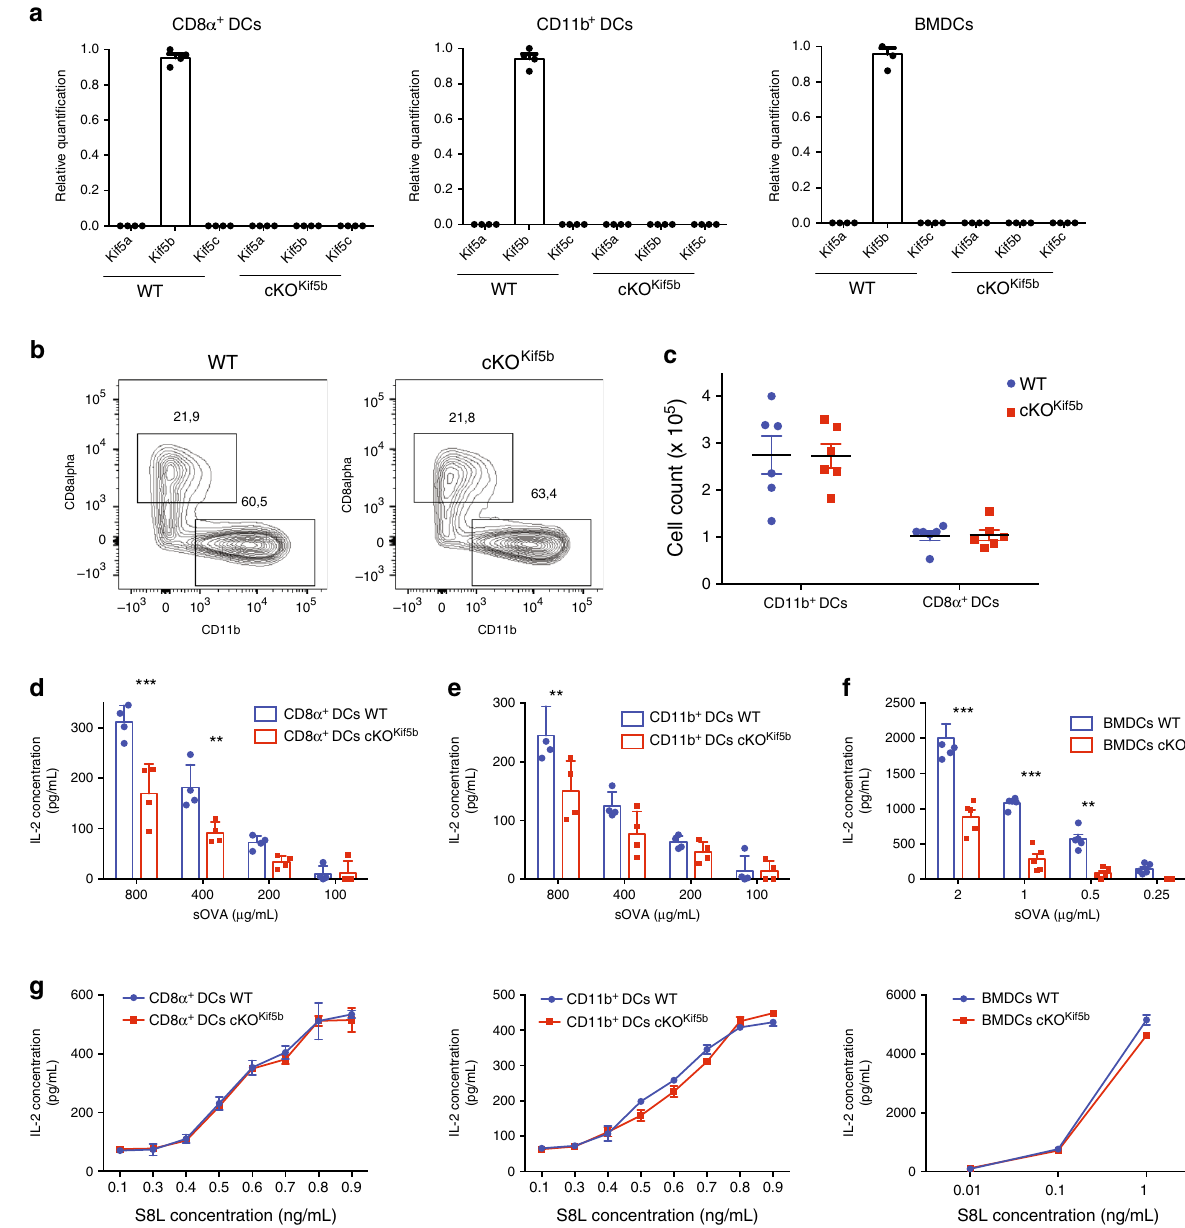
Fig. 1 Kinesin-1 regulates cross-presentation. a Relative quanti fi cation of Kif5a, Kif5b and Kif5c transcripts by real-time PCR in CD8 α + and CD11b + DCs and BMDCs from WT or cKO Kif5b mice. Transcript levels for each sample are expressed relative to Kif5b. Graph shows mean ± S.E.M. ( n = 3). b Contour plots of DCs from the spleen of either WT or cKO Kif5b mice pregated on CD19 − , Gr − , F4/80 − CD11c + , and IA/IE + . The data are representative of three independent experiments. c Absolute numbers of CD11b + DCs and CD8 α + DCs in the spleen of WT (blue circles) and cKO Kif5b (red squares) mice. The data are representative of fi ve independent experiments. d – g The ef fi ciency of cross-presentation of different concentration of sOVA and the presentation of OVA peptide SIINFEKL in vitro by CD8 α + DCs ( d , g ), CD11b + DCs ( e , g ) and BMDCs ( f , g ) from WT (blue histogram or line) or cKO Kif5b (red histogram or line) mice was measured as IL-2 secretion by OT-I T cells after 16 h of co-culture. Graph shows mean ± S.E.M. ( n = 4). Statistical signi fi cance was determined by the two-way ANOVA and Sidak test ’ s correction for multiple comparison. * P < 0.05; ** P < 0.005; *** P <